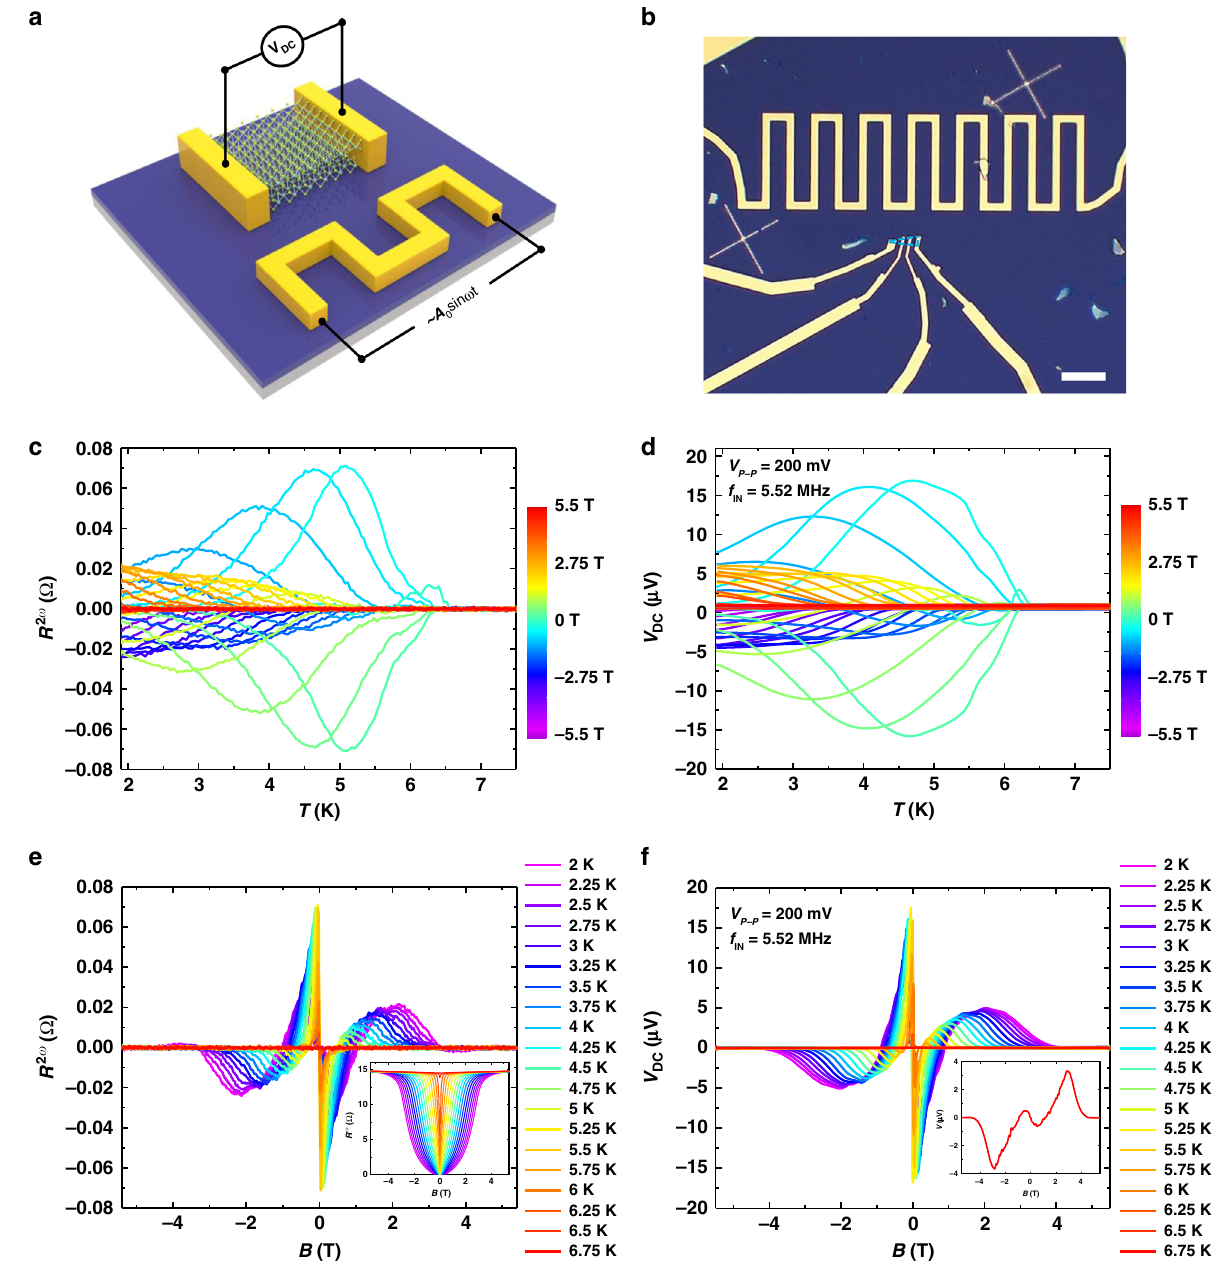
Fig. 4 Nonreciprocal sensitivity in atomically thin NbSe 2 antenna. a , Schematic structure of the NbSe 2 antenna device for the measurement of DC signal. The nanovoltage meter was directly connected to NbSe 2 . Sine wave AC signals were applied to the fabricated resistor. b , Optical image of the antenna device, scale bar, 20 μ m. The NbSe 2 thickness is three layers. c , R 2 ω -T of the device under negative and positive applied magnetic fi elds perpendicular to the substrate (with no AC signal applied on the resistor). d , V DC -B of the device with sine wave AC signal ( V P-P = 200 mV, f IN = 5.52 MHz) applied on the resistor. e , R 2 ω -B curves of the device with the temperature changing from 2 to 6.75 K. Inset, the fi rst harmonic signal of the device measured simultaneously with the second harmonic signal. Both the fi rst and second harmonic signals were measured under no AC signal applied to the resistor. f , DC signal V DC -B of the device with the temperature changing from 2 to 6.75 K with sine wave AC signal ( V P-P = 200 mV, f IN = 5.52 MHz) applied to the resistor, showing similar antisymmetric behavior to the R 2 ω -B curves. Inset, DC signal of the device at T = 2 K with no AC signal applied to the resistor. The antisymmetric signal comes from environmental fl